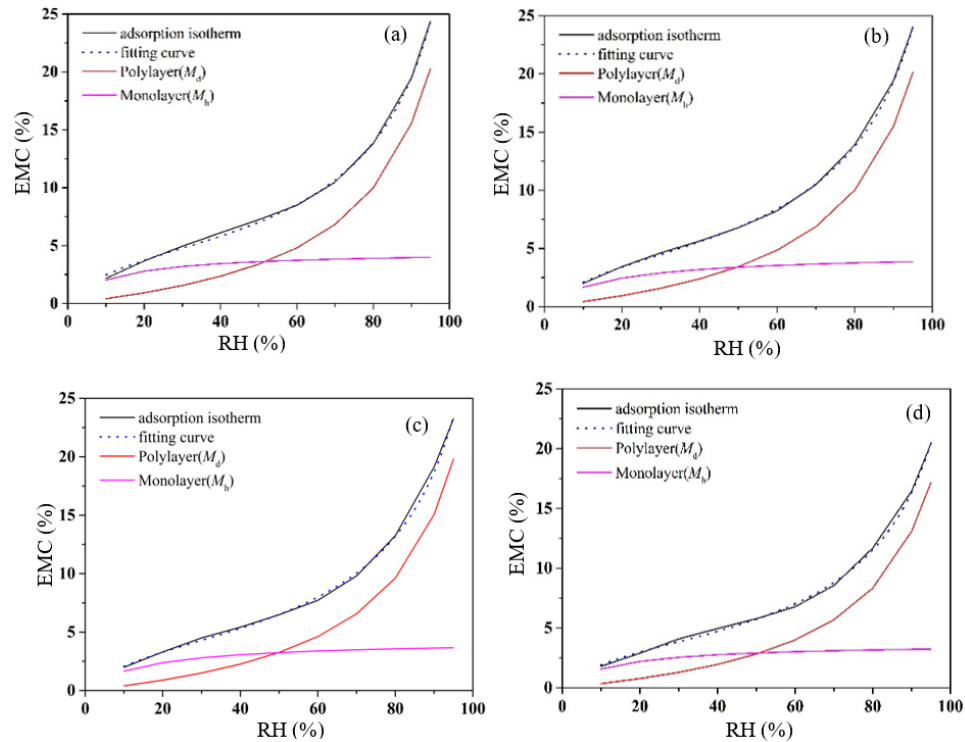
Figure 5. Monolayer and polylayer water determined using the H-H model, and the best fit line of sum of monolayer and polylayer adsorption isotherm using the adsorption isotherm data. Control EW ( a ), 180 E ( b ), 200 E ( c ), 220 E ( d ).